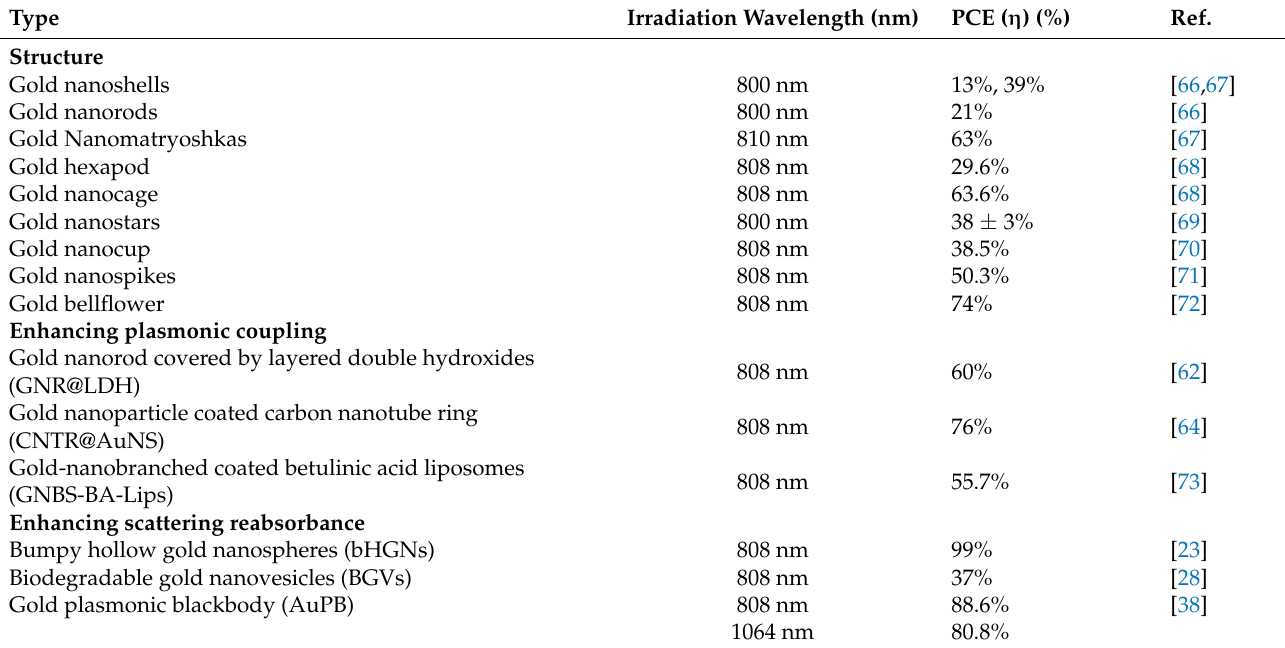
Table 2. Photothermal conversion efficiency of gold